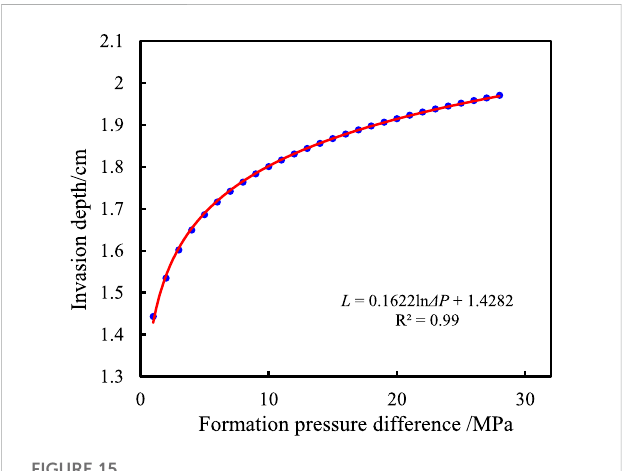
FIGURE 15 Relationship between the invasion depth of the drilling fl uid along the bedding fracture and formation pressure difference.